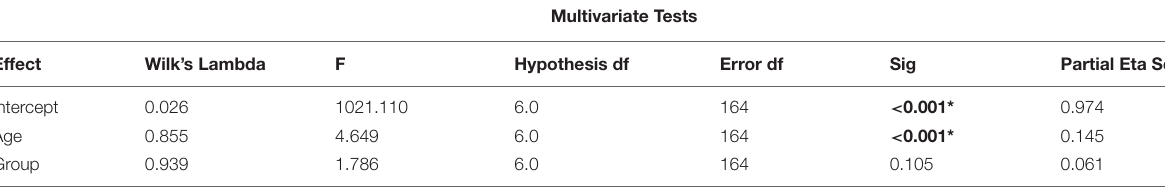
TABLE 5 | Statistical analysis for the multivariate analysis of covariance (MANCOVA) for Group A-Time 1 (time point 1) and Group B. Multivariate Tests